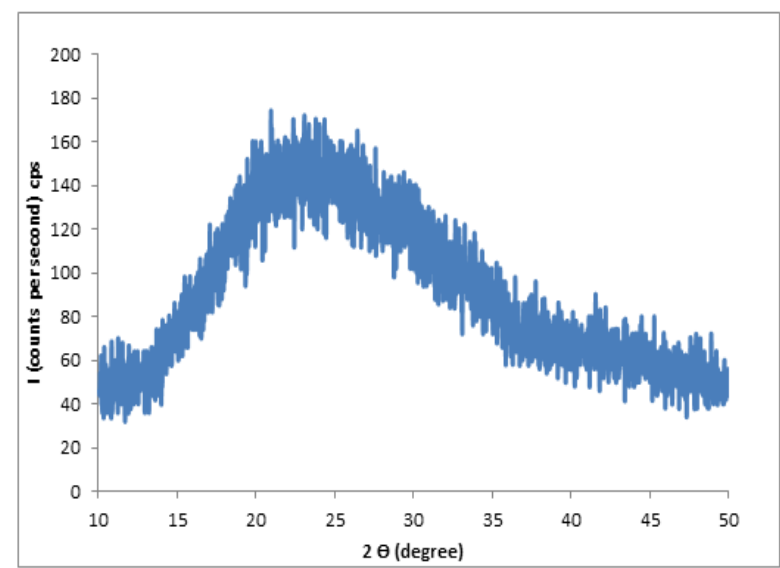
Fig.3: The X-Ray diffraction pattern for synthesized CQDs .